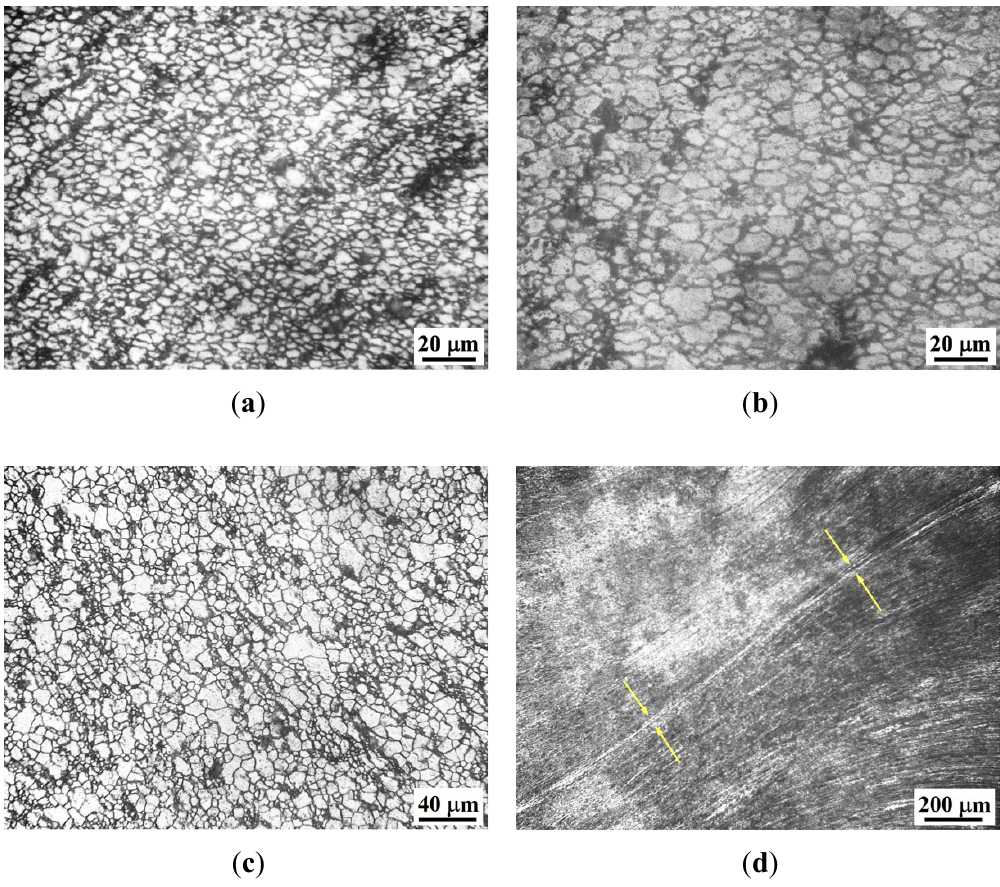
Figure 7. Microstructures obtained on DMD processed AZ31-3Ca alloy deformed at ( a ) 350 ° C/0.0003 0.0003 s − 1 (Domain 1) ( b ) 400 ◦ C / 0.0003 s − 1 (Domain 2) ( c ) 450 ◦ C / 10 s − 1 (Domain 3), and ( d ) 300 ◦ C / s − 1 (Domain 1) ( b ) 400 ° C/0.0003 s − 1 (Domain 2) ( c ) 450 ° C/10 s − 1 (Domain 3), and ( d ) 300 ° C/10 s − 1 10 s − 1 (instability regime). The compression axis is (instability regime). The compression axis is vertical.